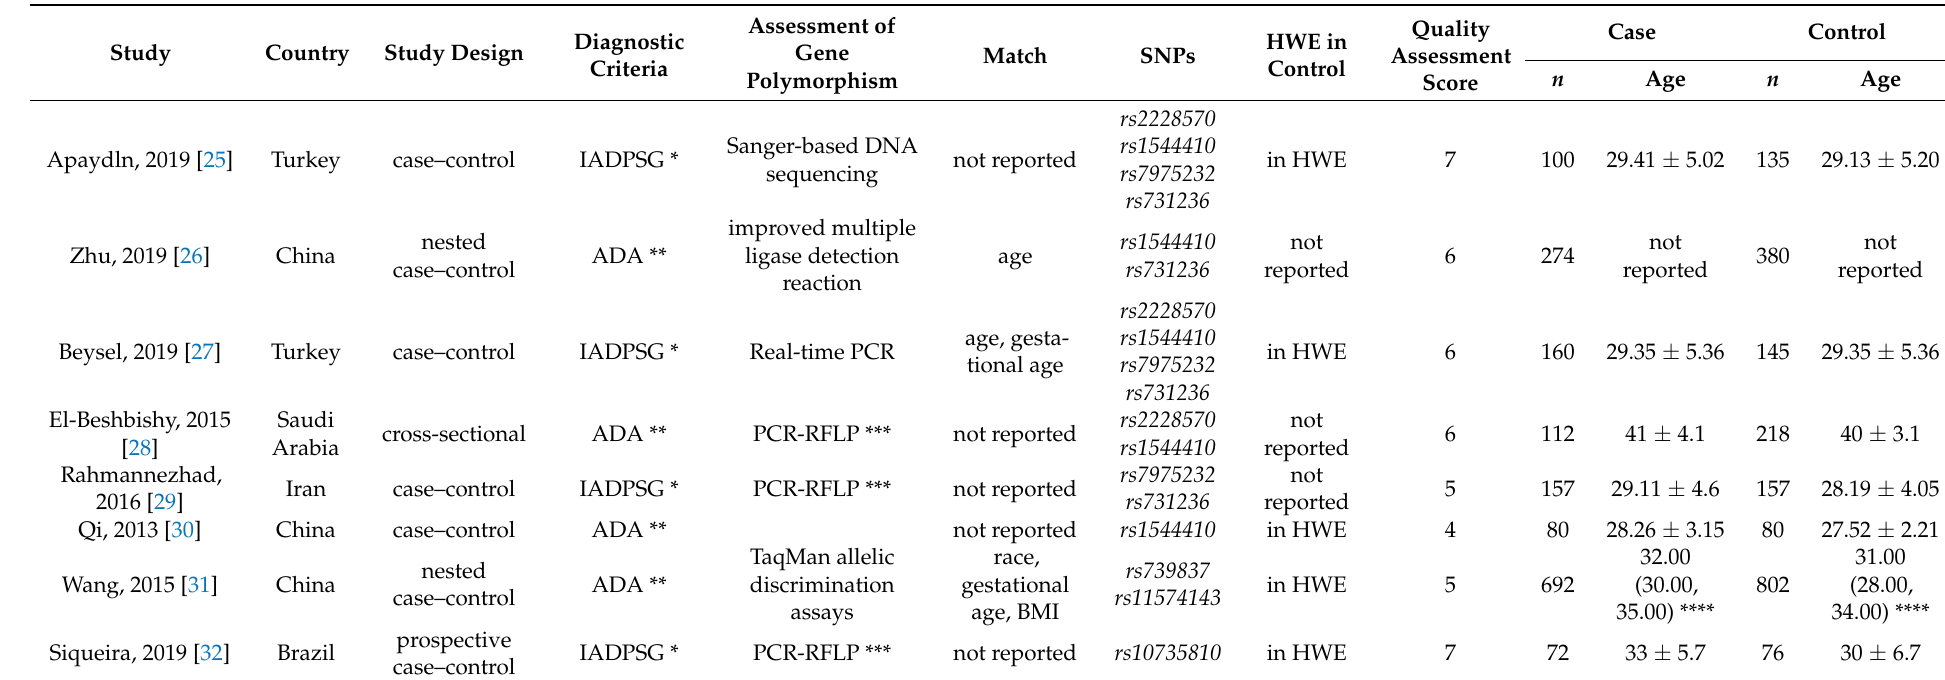
Table 1. Characteristics of the eligible